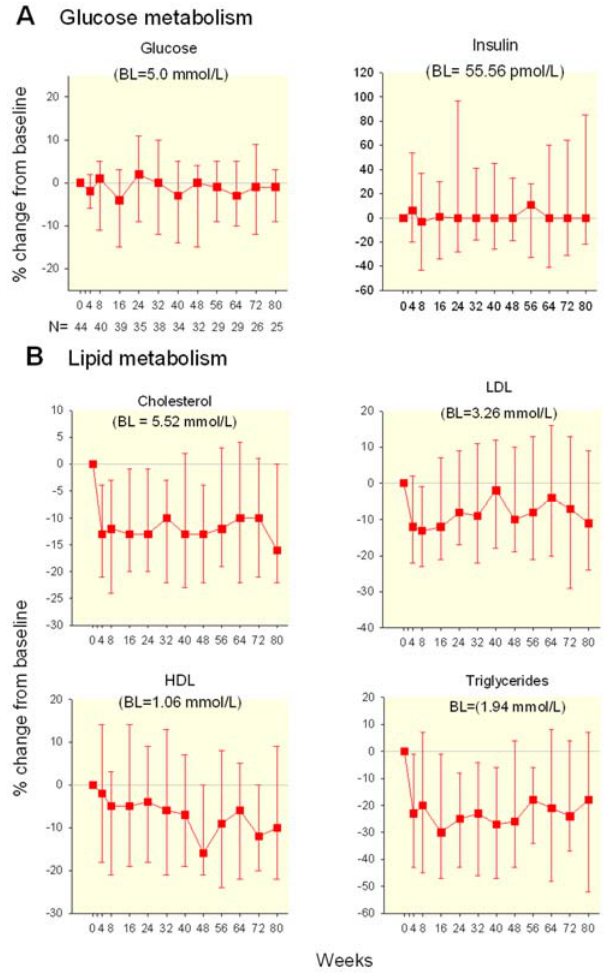
Figure 2. Glucose and Lipid Metabolism During Prolonged TI (median % change from baseline and